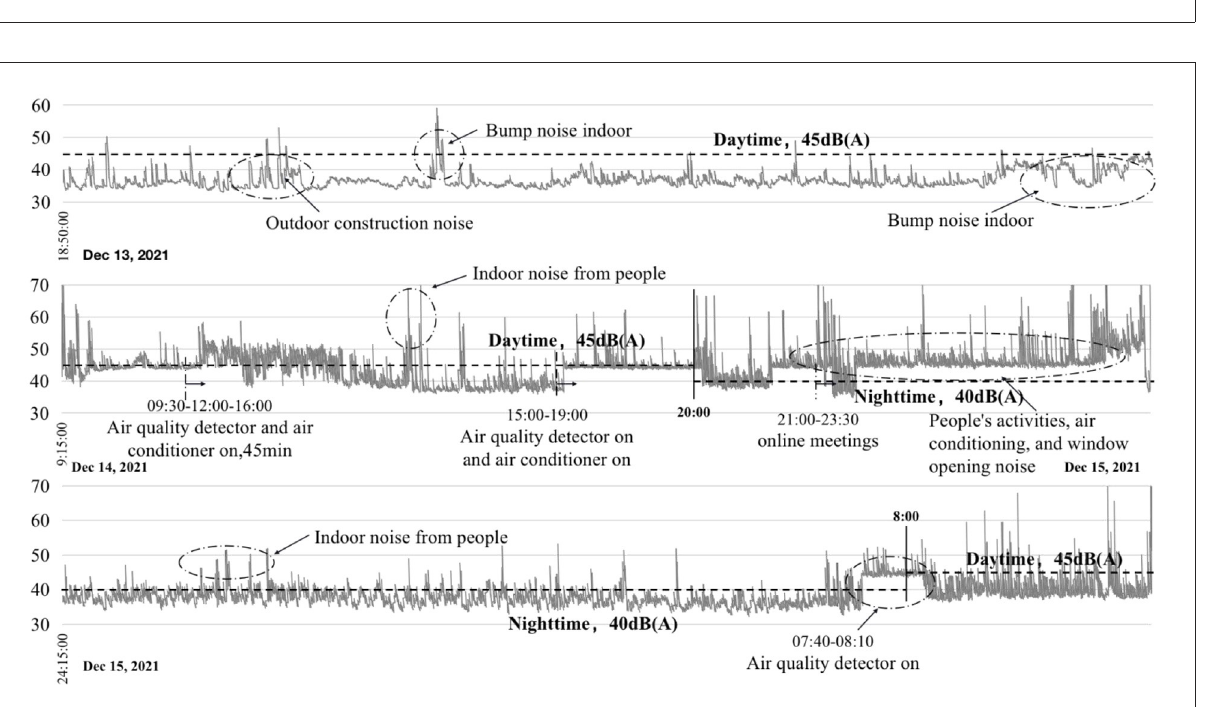
FIGURE8 Recorded noise values from December 13 to